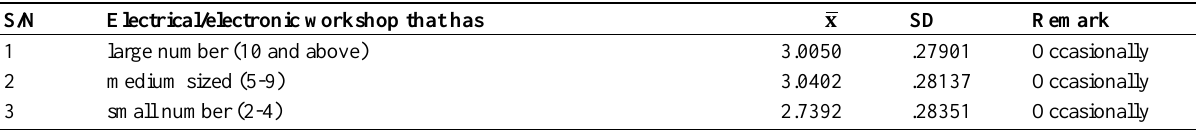
Table 2: Mean Score of Accident Rates in Different Electrical/Electronic Workshops having Different Number of Users S/N